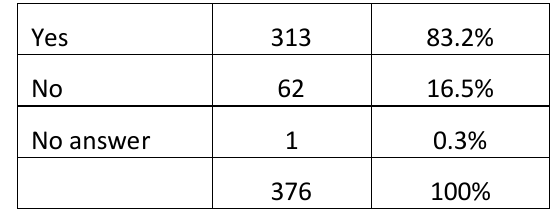
Table 13 : Increase of the readiness to share data in the last 5 years.